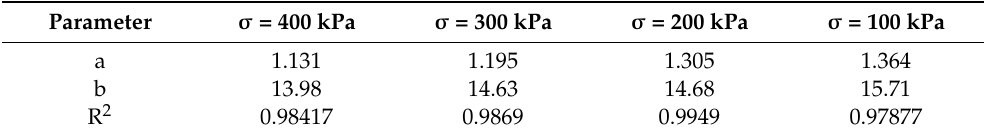
Table 3. The fit parameters of predictive model.